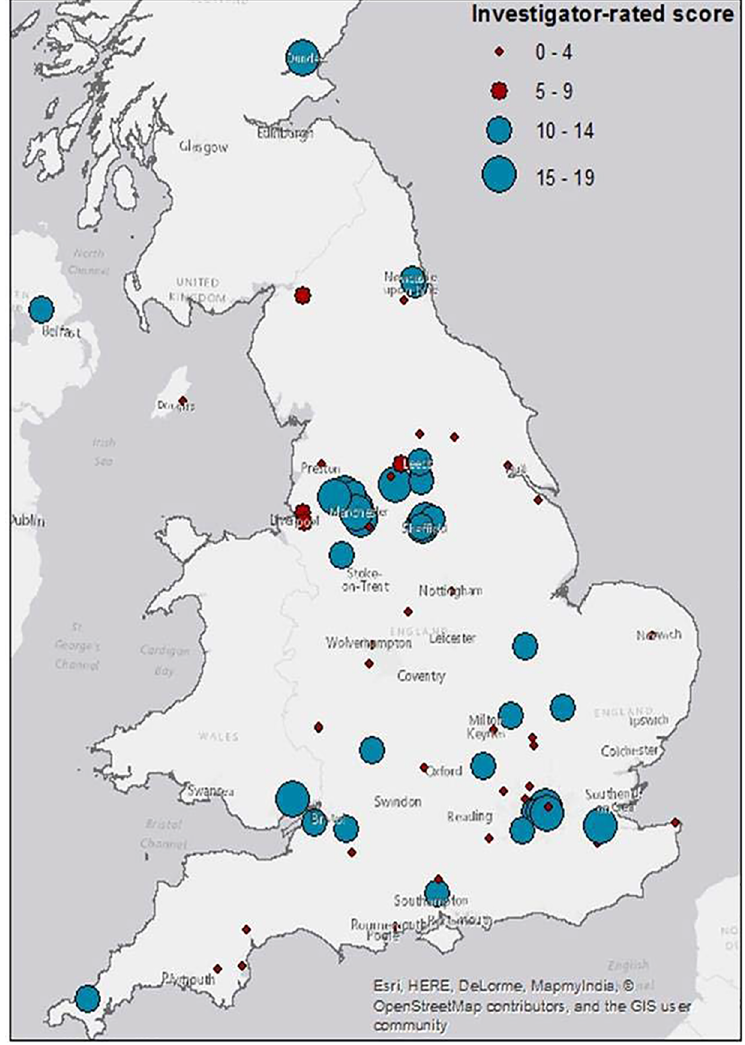
Fig 1. The distribution of survey respondents across the UK based on investigator-rated scores. The blue (larger) circles indicate locations with good (15–19 score) or moderate (10–14 scor e) capability to deliver exercisetraining according to NICE CG175 . The (smaller) red circles indicate no (0–4score) or limited (5–9 score) ability to deliver exercise training according to NICE CG175 . quotes are detailed below. All qualitative data used to construct themes and sub-themes can be found in S5 File.